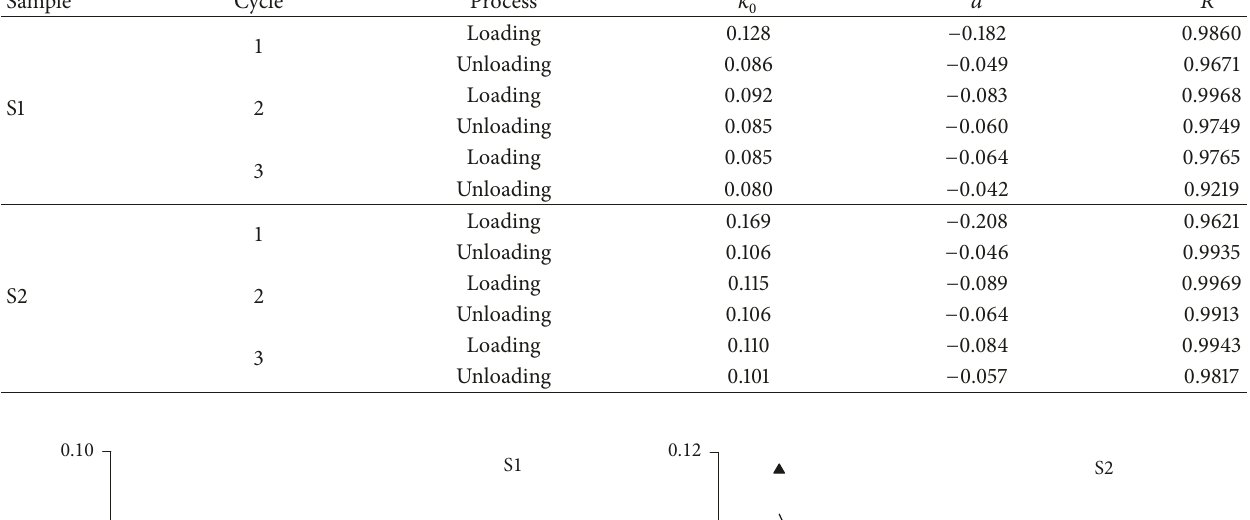
Table 3: Fitting parameters in the mathematical models of permeability and confining pressure.